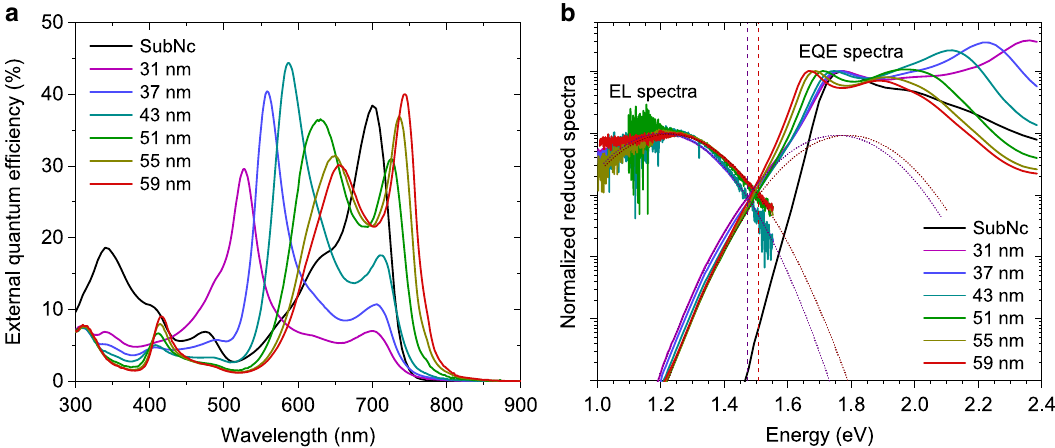
Fig. 3 Effects of strong coupling on EQE and electroluminescence of SubNc/C 60 based cells. a EQE spectra for strongly coupled SubNc/C 60 solar cells, for varying transport layer thickness d . EQE of a reference solar cell utilizing only SubNc ( ‘ SubNc ’ , black) is included for comparison. In the strongly coupled devices, the SubNc peak is split into two polariton peaks which redshift for increasing d . b Sensitively measured normalized reduced EQE and EL spectra of the same devices. The low-energy EQE and high-energy EL edges of the most blue-shifted and red-shifted spectra are fi tted (purple and red dashed lines, respectively) and the crossing point of their Gaussian lineshapes (purple and red dotted lines) provide the CT-state energy in each